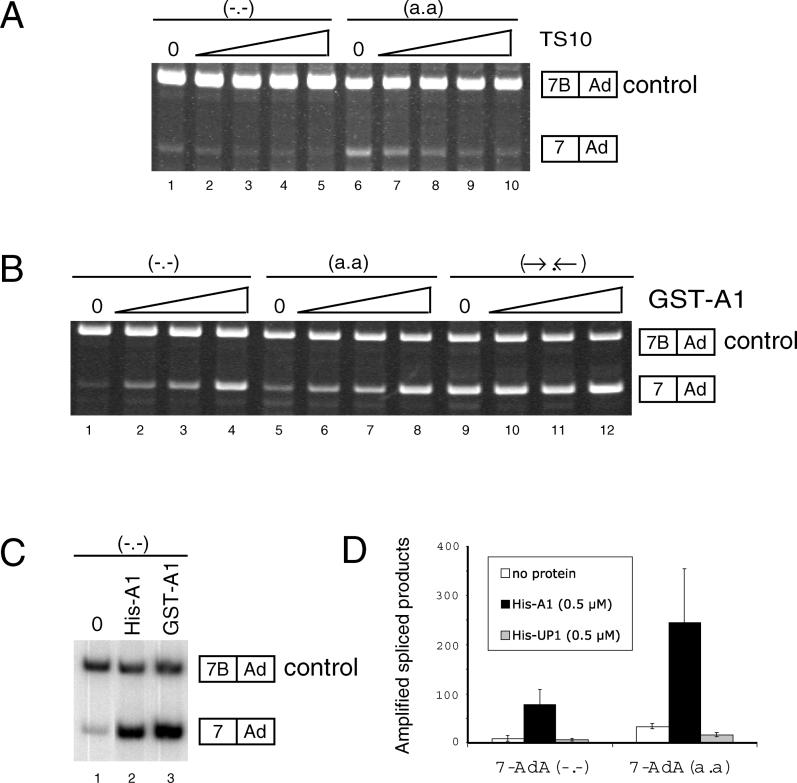
The hnRNP A1 Protein Stimulates Large-Intron Splicing(A) Sequestering hnRNP A/B proteins affects large-intron splicing. The large-intron substrates 7-AdB lacking ABS (−.−) or containing ABS (a.a) were co-incubated with the small-intron 7B-Ad pre-mRNA (80 pM for the 7-AdB substrates and 16 pM for the control 7B-Ad pre-mRNA) in a HeLa extract for 90 min in the presence of increasing amounts of the telomeric oligonucleotide TS10 (0, 80, 160, 320, and 640 nM, respectively).(B) Splicing mixtures were incubated with increasing amounts of recombinant GST-A1 protein (0, 0.8, 1.6, and 3.2 μM). The 7-AdB pre-mRNA carrying inverted repeats (→.←) was also used.(C) Splicing mixtures containing the 7-AdB and the small-intron 7B-Ad were supplemented with His-A1 and GST-A1 (0.5 μM each).(D) The histogram depicts a compilation of three independent experiments performed with the indicated concentrations of recombinant proteins. In each case, individual values obtained for the splicing of 7-AdA (−.−) or 7-AdA (a.a) pre-mRNAs were normalized with the splicing efficiency of the small intron 7B-Ad pre-mRNA. Error bars indicate standard deviations.